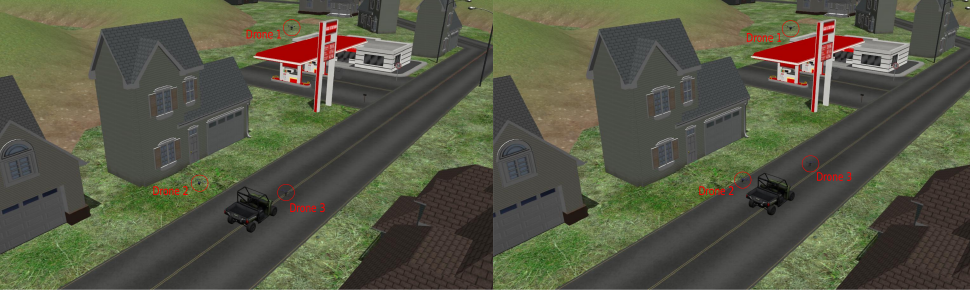
Figure 12. Screenshots of drones executing SA2 and SA3 in our